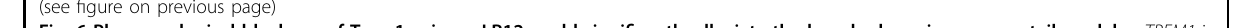
Fig. 6 Pharmacological blockage of Trem1 using mLR12 could signi fi cantly alleviate the lymphedema in a mouse tail model. a TREM1 is predominantly expressed by the pro-in fl ammatory macrophage subpopulation c8. b Changes in the diameter of mouse tail during the treatment using mLR12 ( n = 5) or mLR12-scramble peptides as a control ( n = 5). Starting from 15 days after the surgery, mice were treated daily by intraperitoneal injection. The diameter of the tail (1 cm distal to the incision) was measured every 3 days for 6 weeks. Tail tissue samples were collected 6 weeks after the surgery for subsequent assays. * P value < 0.05, ** P value < 0.01, n.s. not signi fi cant, one-tailed t -test. c Images showing the mouse tails following treatment. d H&E staining of the cross-sections of the mouse tails showing reduced subcutaneous tissue edema in the treatment versus the control group. The double-sided arrow indicates the thickness of subcutaneous tissues. e Thickness of the subcutaneous tissues measured based on the H&E staining images. f Sirius red staining showing decreased fi brosis. Collagens were stained in red. Collagen fi bers are disarrayed in the fi brosis of the scramble group. g Immuno fl uorescent staining showing a reduced number of Cd11b + Trem1 + cells in the treatment group (lower panel) versus the control group (upper panel). The arrows indicate the Cd11b + Trem1 + cells. h Proportion of the Cd11b + Trem1 + macrophages in all Cd11b + cells in the two groups based on the immuno fl uorescent staining. i Reduced mRNA expression of Cd68 in the mouse tail tissue following the LR12 treatment. j Reduced mRNA expression of Il1b in the mouse tail tissue following the LR12 treatment. k Reduced mRNA expression of Tnf in the mouse tail tissue following the LR12 treatment. In e , h – k , the signi fi cant threshold was set to be a P value of the one-tailed t -test < 0.05 ( n = 3). In d , e , sections at almost the same level (located 1 cm distal to the surgical site) were used for both